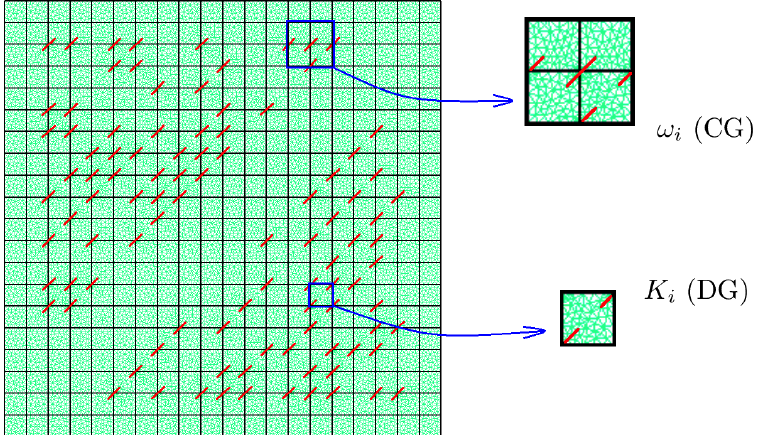
Figure 2. Coarse grid and local domains illustration for CG-GMsFEM and DG-GMsFEM . Fractures are depicted in red color. Structured 20 × 20 coarse grid (black color). Unstructured fine grid (green color) with triangular elements that conformed with